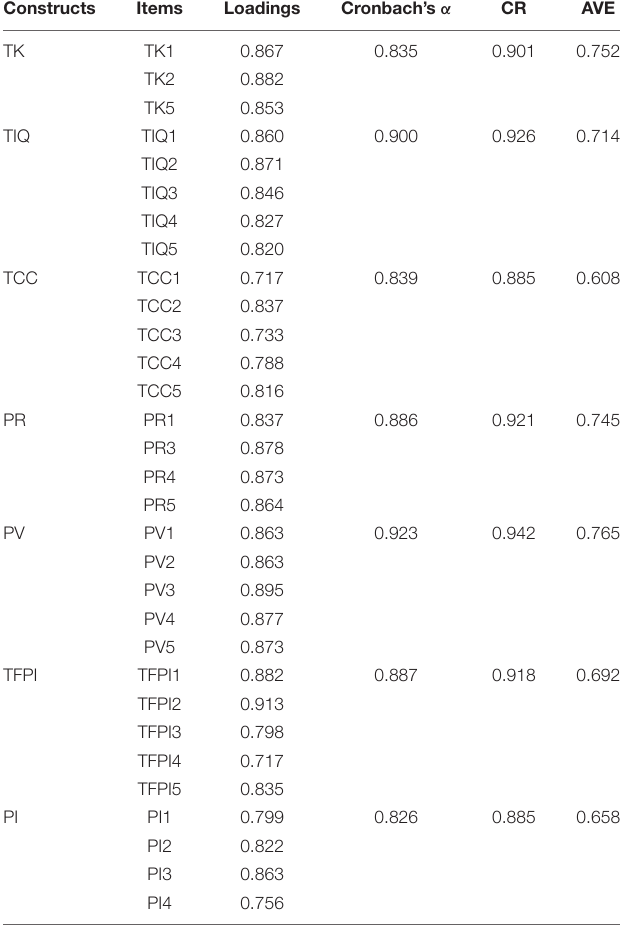
TABLE 3 | Confirmatory factor analysis and scale reliability.